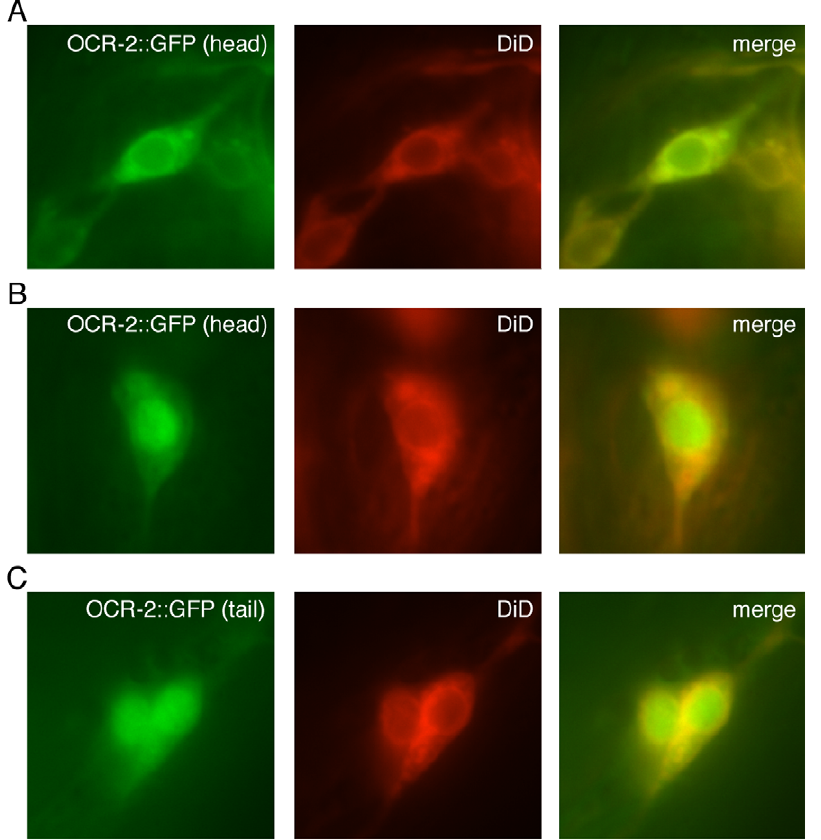
Figure 4. A GFP fusion to the carboxy-terminus of the full-length OCR-2 channel can be detected in the nucleus. GFP was fused downstream of and in frame with full-length OCR-2 and expressed under the control of the ocr-2 promoter ( ocr-2p::ocr-2::gfp ). Transgenic animals were incubated with the lipophilic dye DiD (shown in red), which is taken up by several of the OCR-2 expressing neurons and was used to visualize the neuronal cell body. (A) As previously reported for an amino-terminal GFP fusion [5], flourescence was detected in the cell body and cilia of the AWA, ASH, ADL and ADF head neurons and PHA and PHB tail neurons [5]. The cell body of a head neuron is shown. (B–C) In 82/203 (40%) transgenic animals examined, distinct nuclear accumulation of GFP was detected in at least one neuron. Head (B) and tail (C) neurons are shown. Numbers represent the combined data of 3 independent transgenic lines. To show the animal-to-animal variability in subcellular localization within a transgenic line, all three images shown here were obtained from a single